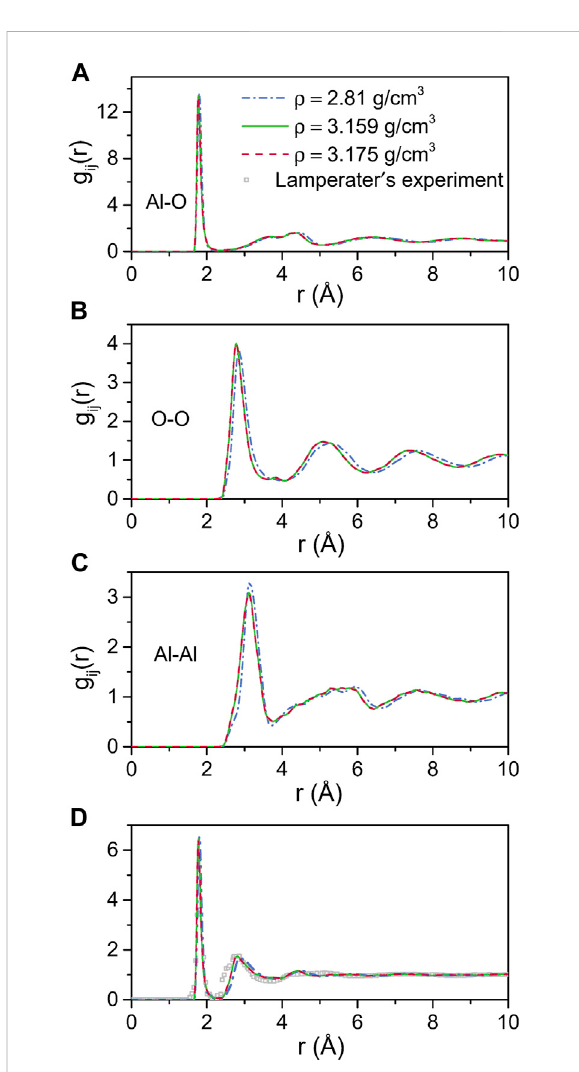
FIGURE 1 MD results for total and partial pair distribution functions for amorphousaluminaat300 Kandthreedensities. (A) Al-O, (B) O-O and (C) Al-Al partial pair distribution functions, (D) Comparison with the neutron pair distribution function from Lamperater ’ s